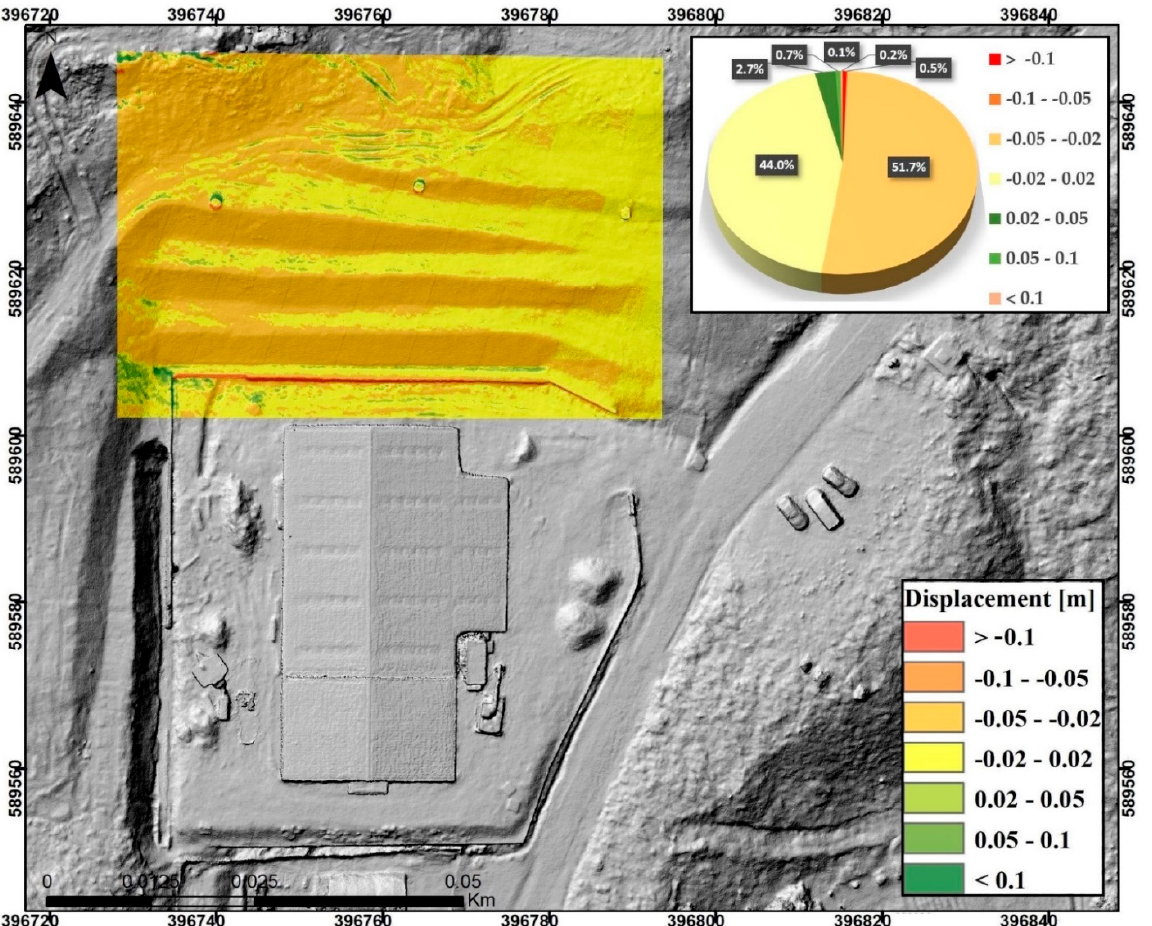
Figure 12. Surface movement rate from 2017 to